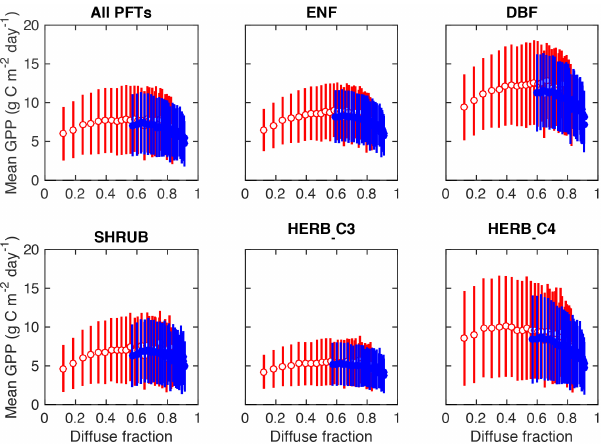
Figure 4. Mean summer GPP for different diffuse fractions. Results shown are for clear-sky (red empty points) and all-sky (blue solid points) conditions. Separately for clear-sky and all-sky conditions, we first collect all grid cells in eastern China (box region in Fig. 2a) for all 30 sensitivity simulations. We then aggregate all grid cells with non-zero fraction of a specific PFT into 30 AOD bins ranging from 0 to 6 at an interval of 0.2. In each bin, we calculate average diffuse fraction and corresponding GPP, with an error bar indicating one standard